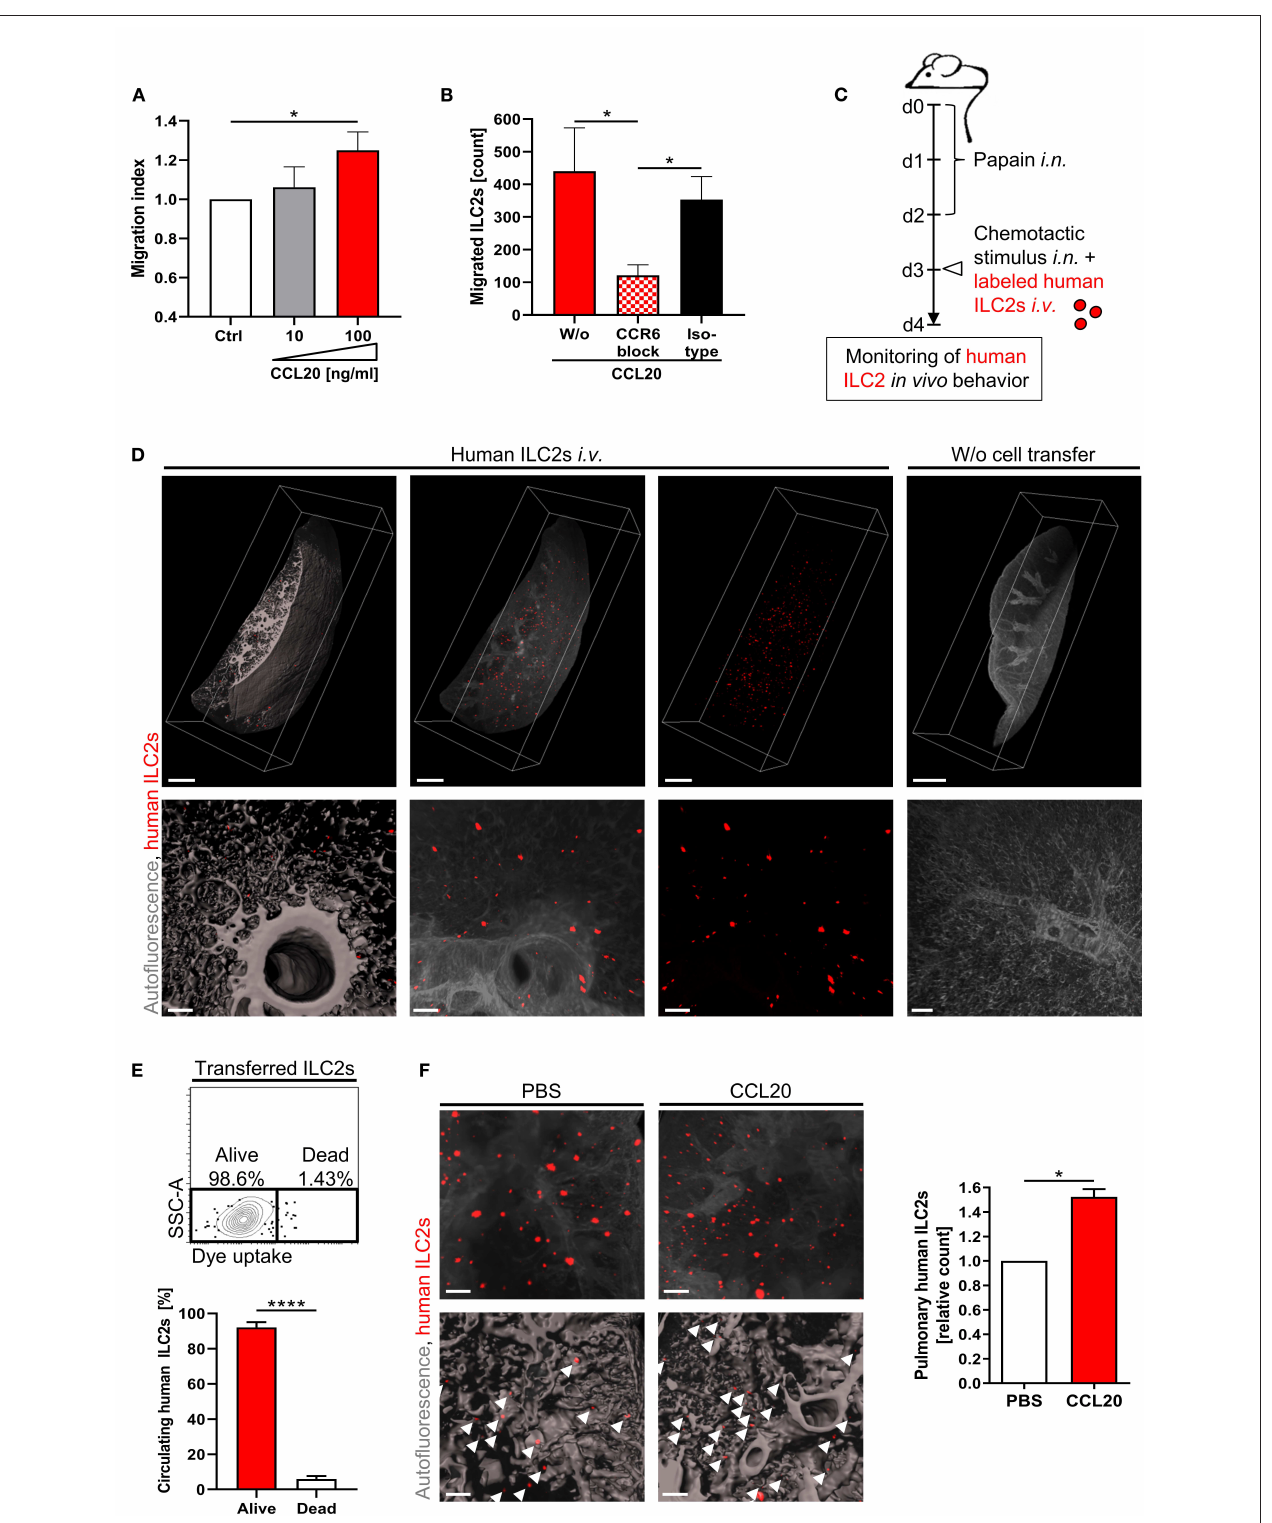
FIGURE 3 | CCR6-CCL20-dependent accumulation of human pb ILC2s in the inflamed lung. (A) In vitro migration of CRTH2 + human PBMCs derived from healthy subjects towards CCL20. Migrated ILC2s (Lin neg CD161 + CRTH2 + lymphoid cells) were flow cytometrically quantified in the bottom chamber ( n = 9). (B) Effect of a